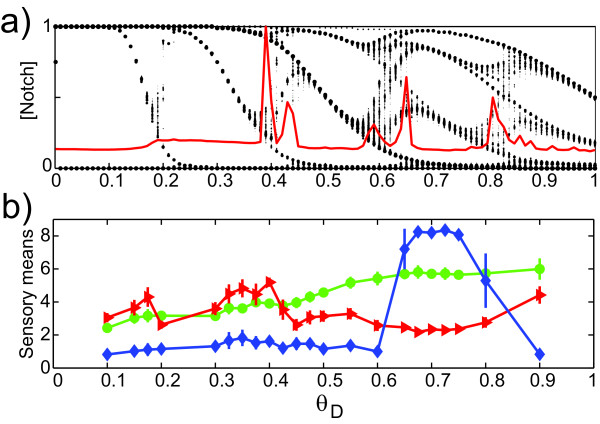
(a) The Notch differentiation pattern obtained for 0 <θD < 1 in the 51 × 51 lattice with periodic boundary conditions. Patterns with θD ≅ 0.1 belong to Class I, with θD ≈ 0.7 to Class III. The superimposed solid curve shows the relative convergence time required to reach the stable state. Other parameter values: θN = 0.1, pD = 10, pN = 3, μ = 0.5, M = 1, and s = 0.2. (b) Weighted averages of the ratings of Whiteness (green), ThicknessCurls (red), and Twoheadedness (blue) by the sensory panel vs. θD in the 51 × 51 lattice with periodic boundary conditions (see Additonal file 1: Table S-T7). Vertical bars indicate standard deviations. The broad maximum for Twoheadedness corresponds to class III.